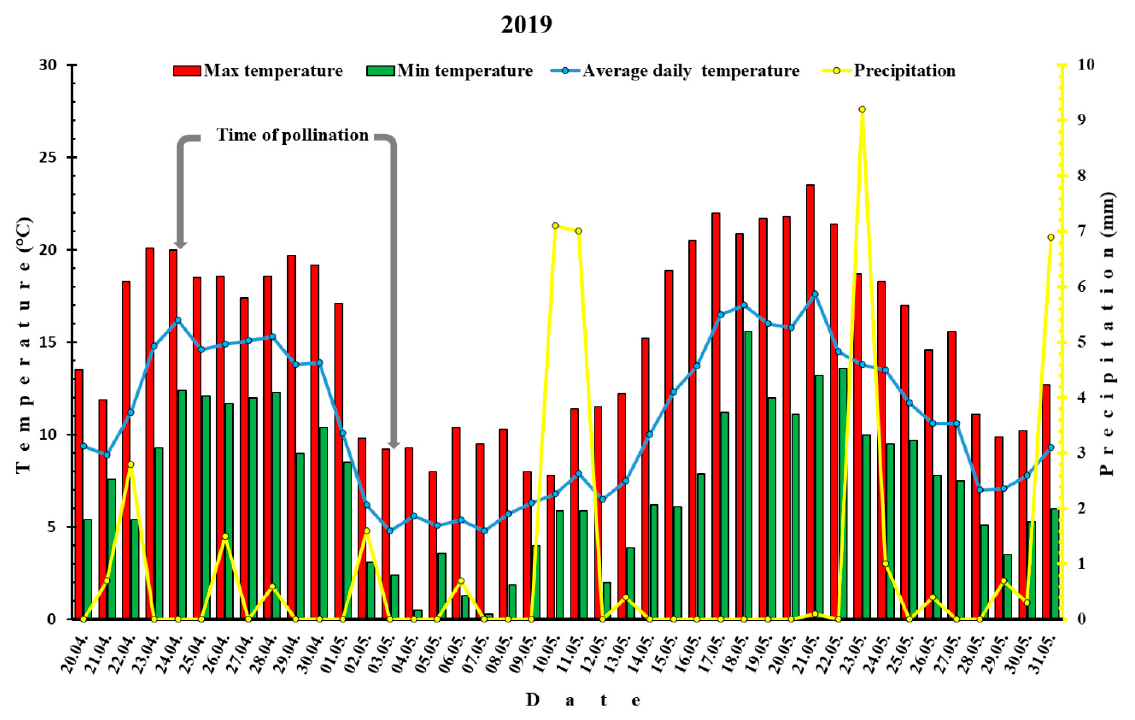
Figure 2. Temperatures (min, max and average) and precipitation before and after pollination of plum cultivars in 2019.